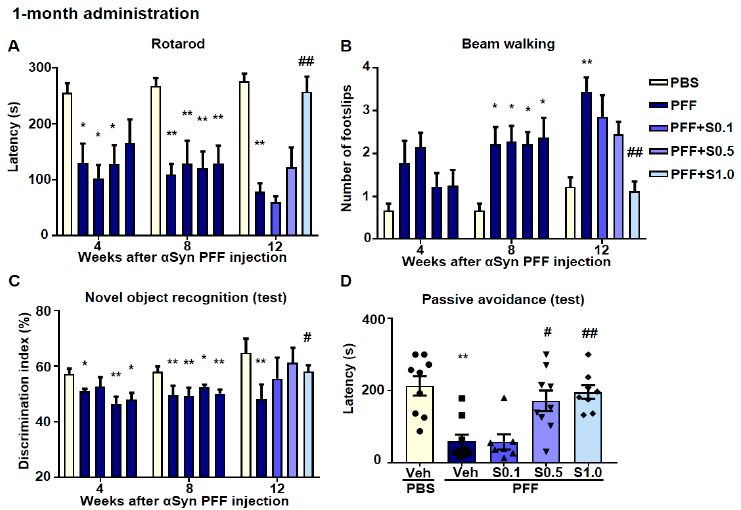
Figure 8. High-concentration treatment with SAK3 for 1 month improves cognitive and motor functions in α -Syn PFF-injected mice. Analyses of motor function based on the ( A ) rotarod task ( n = 10–12 per group) and ( B ) beam-walking task ( n = 10–12 per group) at 4, 8, and 12 weeks after mouse α -Syn PFF injection. ( C ) Test session of the novel object recognition task ( n = 10–12 per group). ( D ) Test session of the step-through passive avoidance task ( n = 10–12 per group). Error bars represent SEM. * p < 0.05, ** p < 0.01 vs. vehicle-treated PBS injection mice; # p < 0.05, ## p < 0.01 vs. vehicle-treated α -Syn PFF-injected mice. Abbreviations: Veh = vehicle; S =